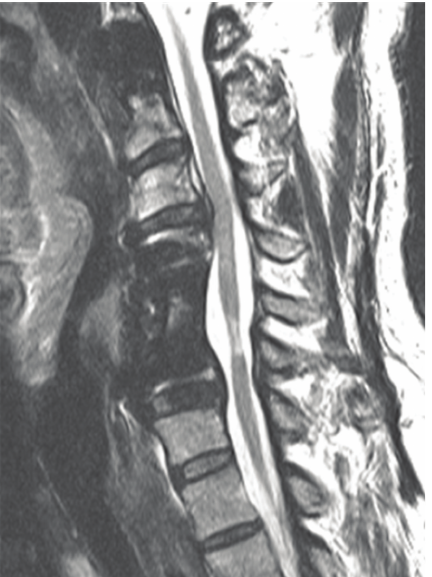
F 6: Sagittal T2-weighted MRI at the latest 16-month followup showing a persistent “white cord